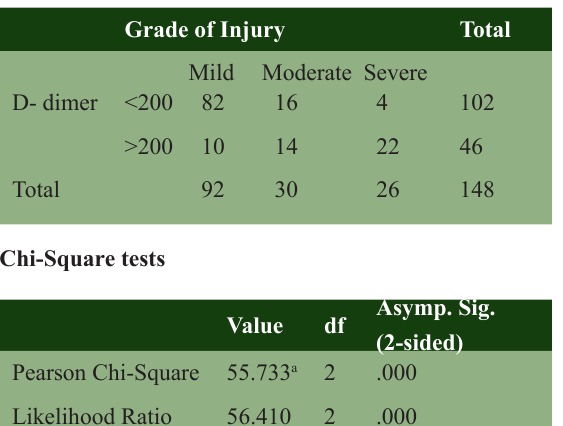
Table 4: Chi-square test showing correlation of D-dimer with grade of injury Grade of Injury